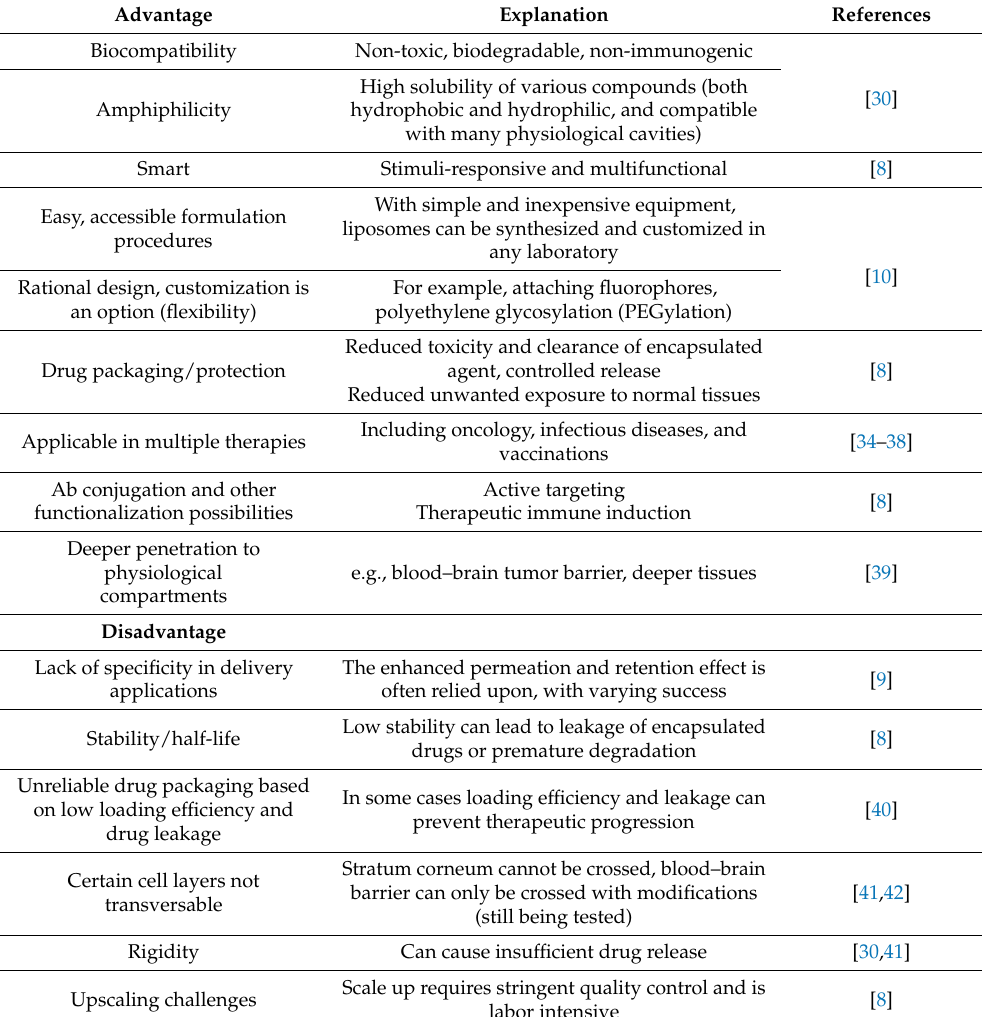
Table 1. Advantages and disadvantages of